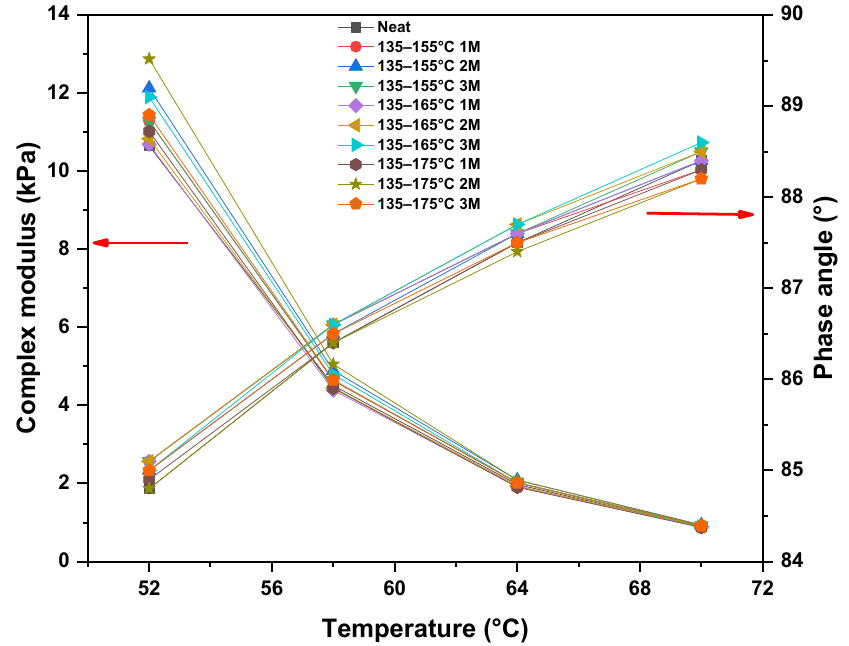
Figure 20. Complex modulus and phase angle under different temperatures at the unaged stage.